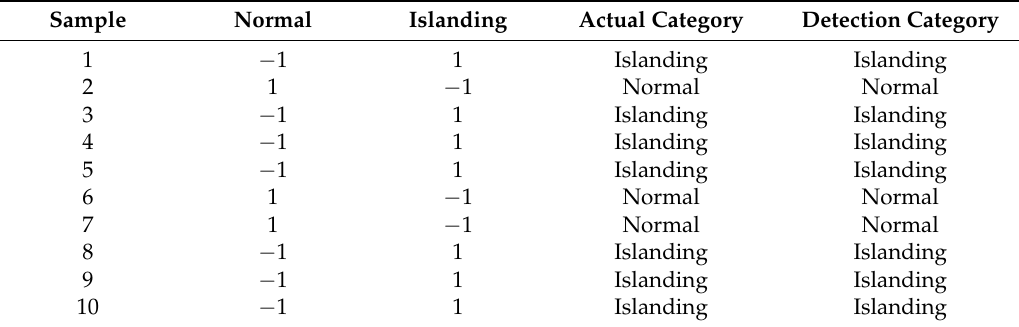
Table 2. Real-time monitored results (correlation).